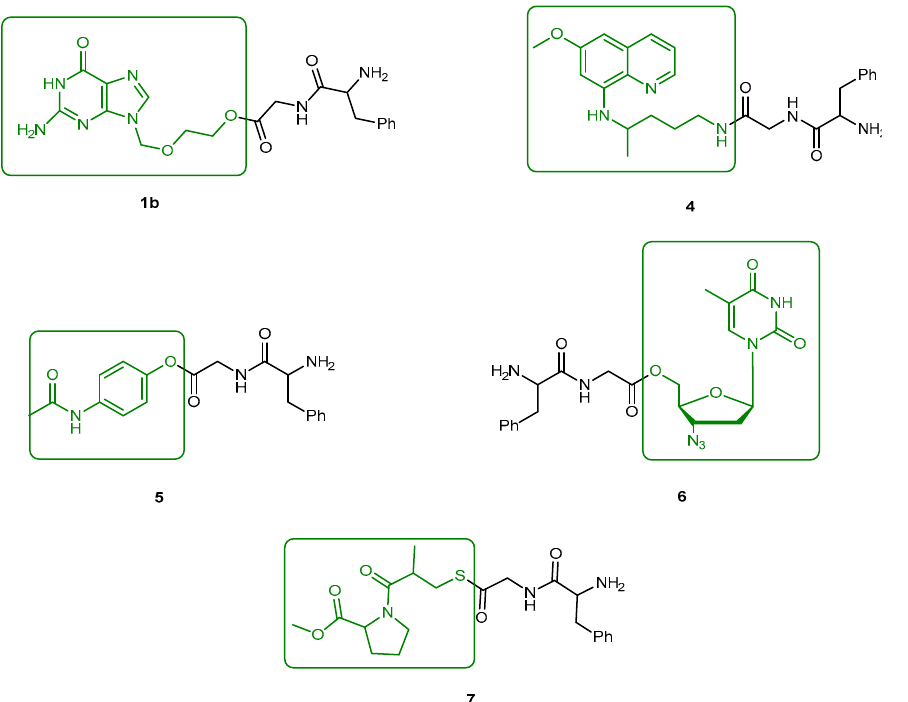
Figure 4. The Phe-Gly derivatives of 1a , primaquine ( 4 ), paracetamol ( 5 ), azidothymidine ( 6 ) and captopril methyl ester ( 7 ). The parent drugs are highlighted in green.